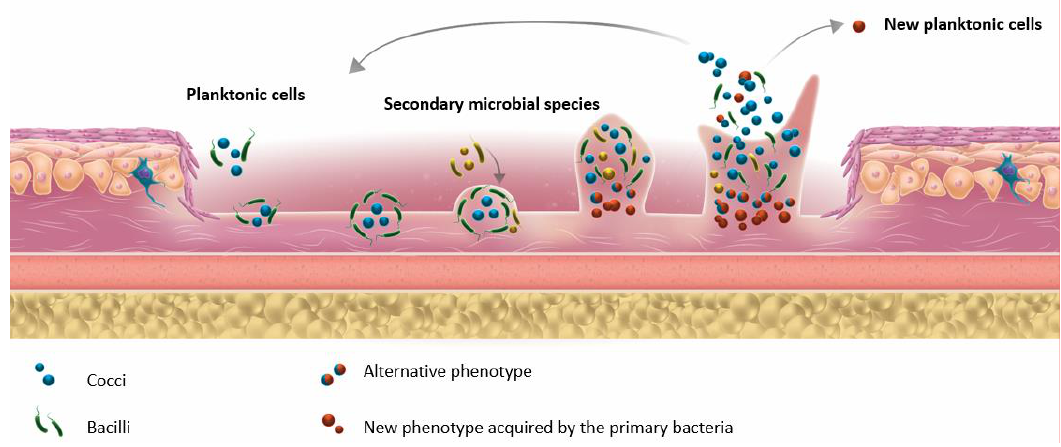
Figure 1. Different bacterial steps of biofilm formation. Figure 1. Di ff erent bacterial steps of biofilm formation. Figure 1. Di ff erent bacterial steps of biofilm